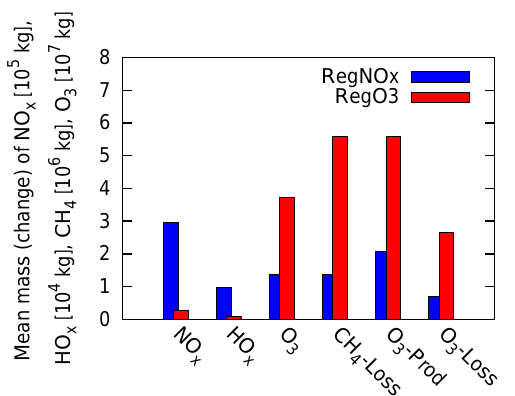
Figure 9. Mean contributions to NO x -related species and produc- tion or loss terms for the RegNO x regime (NO x dominated, blue) and RegO 3 regime (O 3 dominated, red), respectively. Values are given as temporal means over the two time periods.